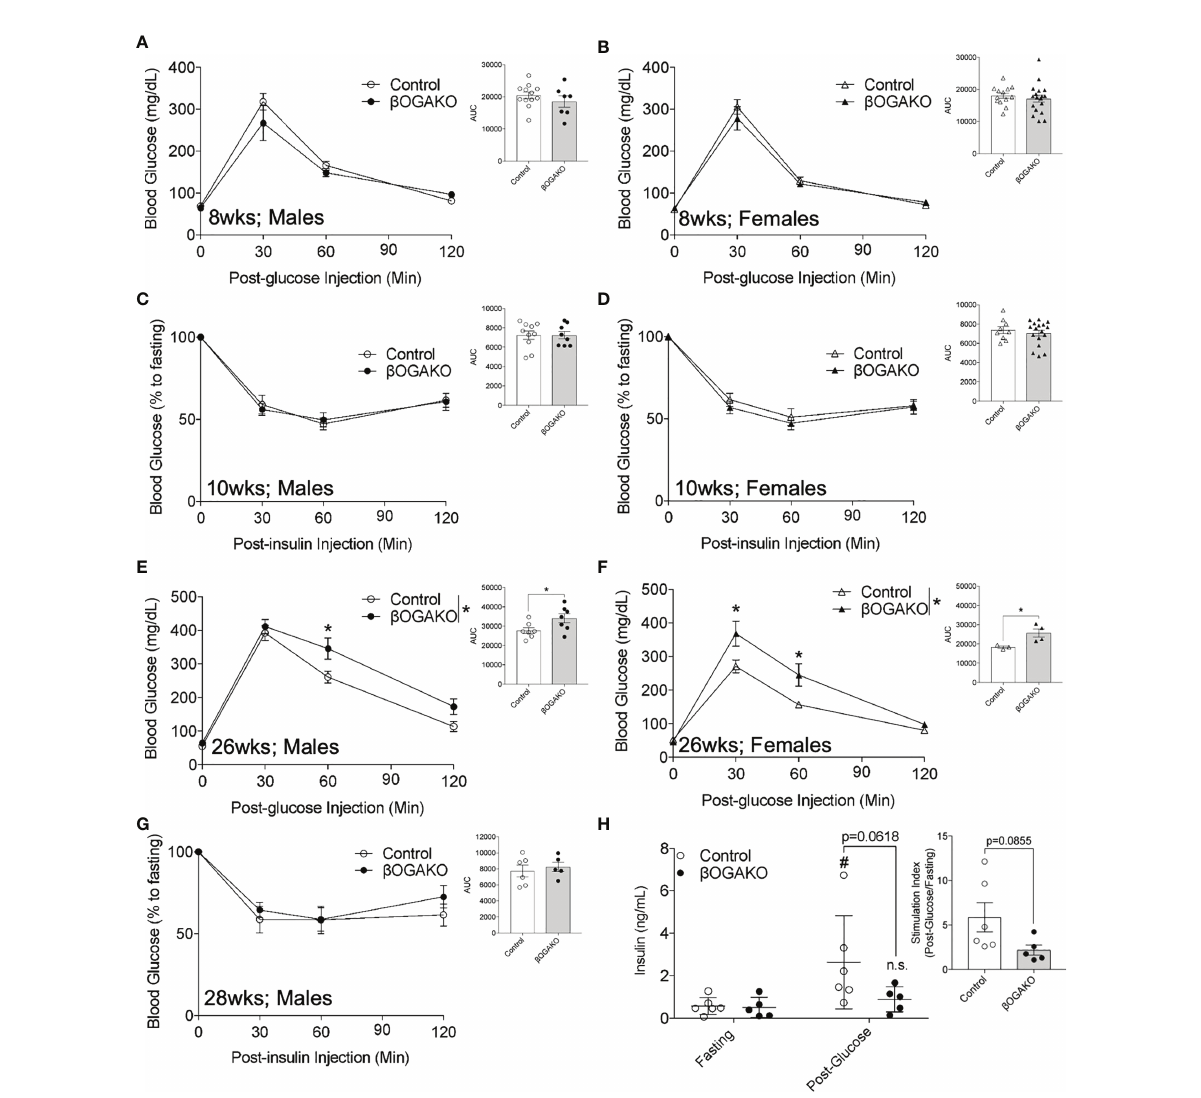
FIGURE 2 Loss of OGA in b -Cells Leads to Glucose Intolerance in Age-Dependent Manner in normal chow diet. In vivo glucose tolerance (2 g/kg glucose, i.p.) test of 8-wks ( A , Male, n=7-12; B , Female, n=13-17) and insulin sensitivity (0.75 U/kg insulin, i.p.) of 10-wks ( C , Male, n=8-10; D , Female, n=9-15). Glucose tolerance test of 26-wks ( E , Male, n=7; F , Female, n=3-4) old mice and insulin of 28-wks old male ( G , n=5-6) mice. In vivo glucose stimulated insulin secretion of male ( H , n=5-6) with calculated stimulation index. Area under curve (AUC) of the blood glucose curves are presented for each fi gure. Statistical analyses were conducted using two-way ANOVA and unpaired, 2-way student t-test with signi fi cance *p < 0.05, #p<0.05 relative to fasting control. ns, non-statistical signi fi